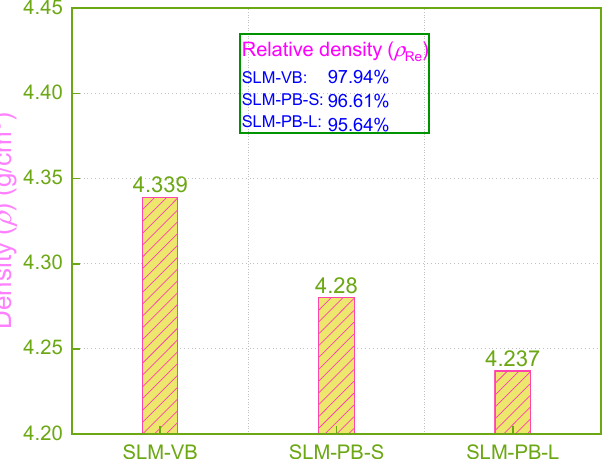
Figure 6. Density of different samples.